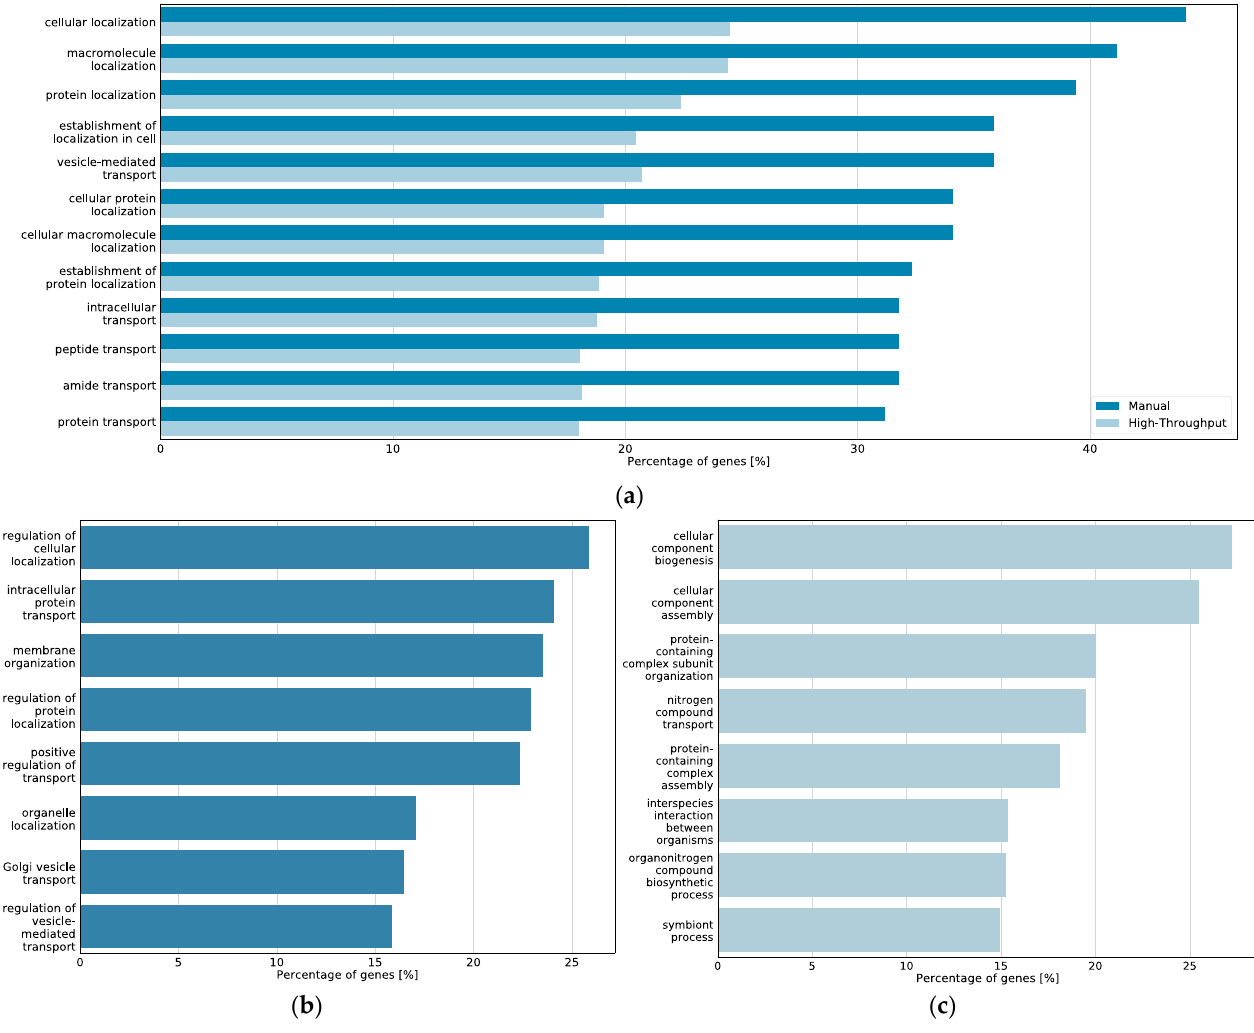
Figure 5. Top 20 prioritized Gene Ontology processes from BioInfoMiner analysis of the CFTR Lifecycle Map. ( a ) Bar plot of the processes prioritized among the top 20 in both the core map and the coarse map datasets and percentage of genes from the respective map associated with the processes; ( b ) bar plot of the processes prioritized among the top 20 in only the manually curated gene list of the core map and percentage of genes from the core map associated with the processes; ( c ) bar plot of the processes prioritized among the top 20 in only the high-throughput interactome of the coarse map and percentage of genes from the coarse map associated with the